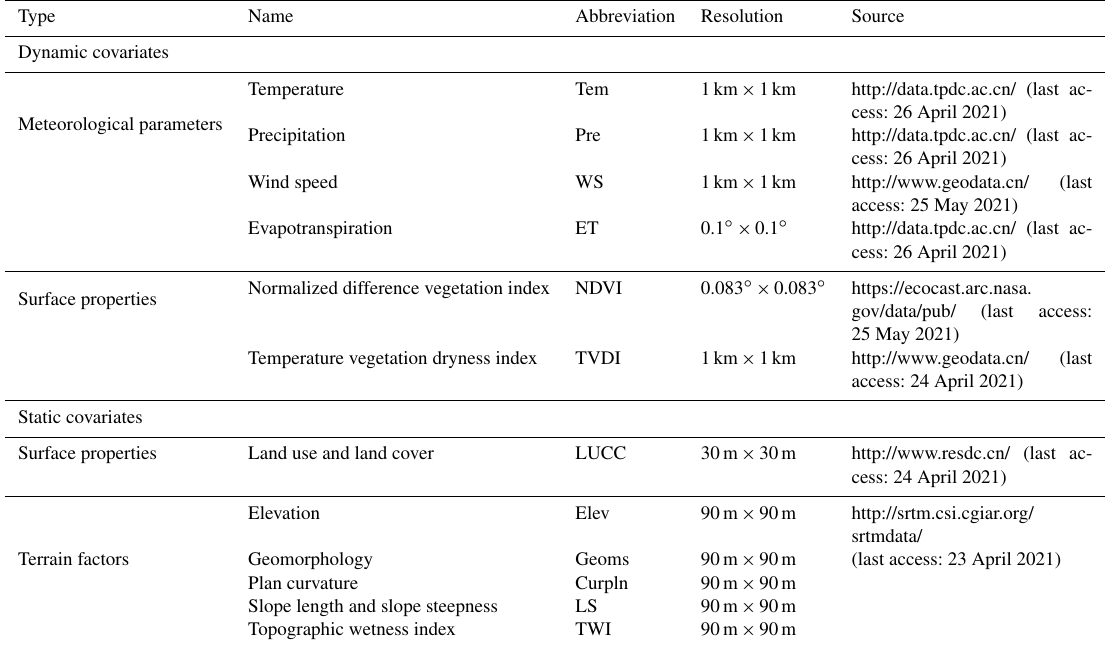
Table 1. Environmental covariates for AOD modeling.